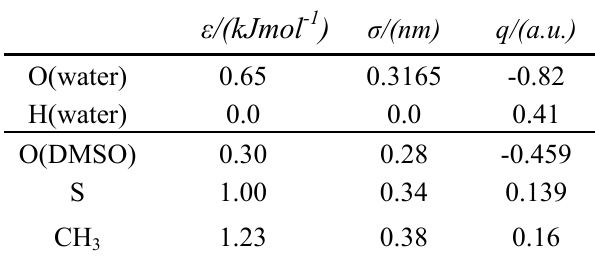
Table 1. L-J parameters and partial charges for water and DMSO.